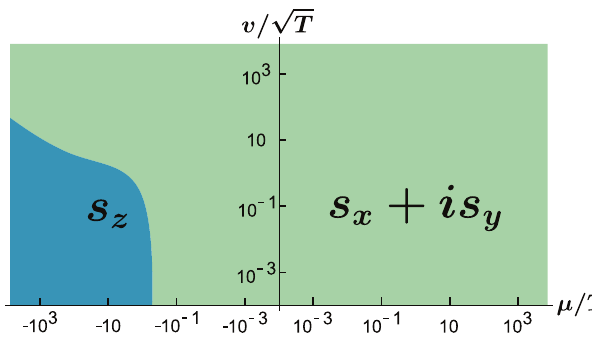
ffiffiffi p T : time-reversal